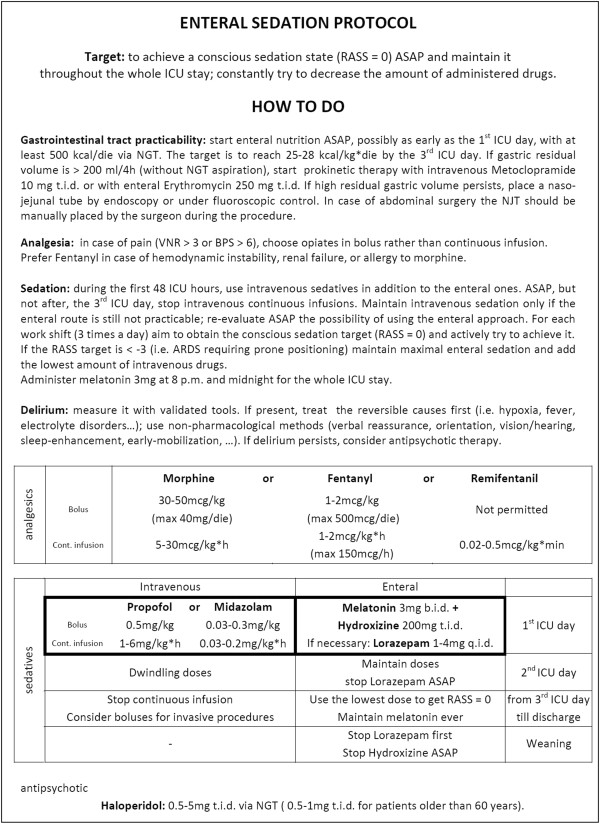
Intervention arm: enteral sedation. Local guidelines for conscious enteral sedation, adopted since 2001 in A.O. San Paolo - Polo Universitario, Milan, Italy following a multidisciplinary commission composed by intensivists, neurologists, and psychiatrists.